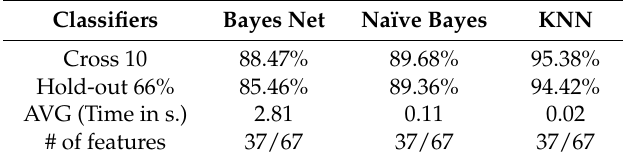
Table 7. Results using Fisher Score of all features for Secure Password DB 150.